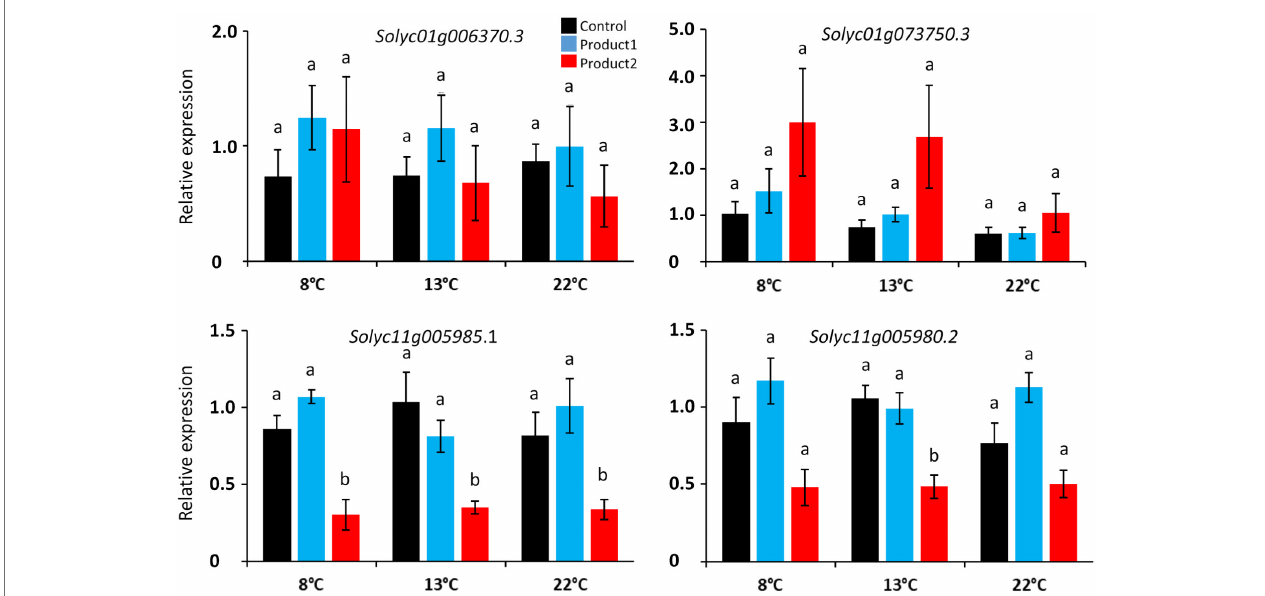
FIGURE 5 | Relative expression of CalS and CalS -like genes in pollen tubes cultured for the duration corresponding to D 8 ° C, D 13 ° C, and D 22 ° C. Different colors correspond to pollen tubes cultivated in control conditions (black), or in a medium supplemented with 2 μ g.ml − 1 of P1 (blue) or P2 (red) at 8, 13, and 22 ° C. Relative expression corresponds to the mean of 6 biological replicates normalized against four reference genes ( EXP , LZ , EF1 α , and CK2A ). Statistical analyses were carried out by one-way ANOVA and significant differences were analyzed by Dunnett’s multiple comparison test. Data are marked by different letters when significantly different to the control conditions at each temperature ( p <